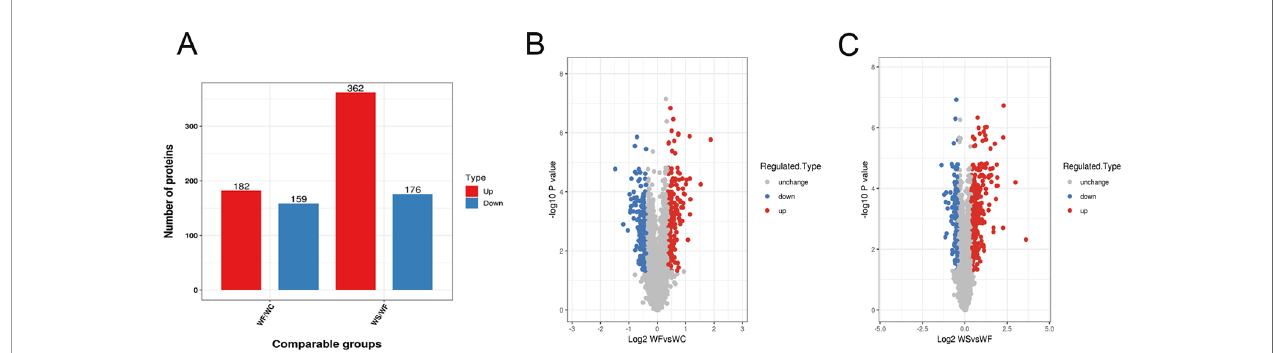
FIGURE 3 | Quantitative information on differential protein identi fi cation. (A) Histogram of the number distribution of differentially expressed proteins in WF/WC and WS/WF, two different comparison groups; (B , C) Volcano plot of differentially expressed proteins. The horizontal axis is the relative quantitative value of protein after Log2 logarithm conversion, and the vertical axis is the p-value of difference signi fi cance test after Log10 logarithm conversion. The red dots indicate the signi fi cantly different expressions of up-regulated proteins, while the blue dots indicate the signi fi cantly different expressions of